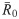
(above) Bivariate posterior distribution of R¯0 and initial susceptible proportion in 2011 for H1N1pdm09. Points indicate accepted ABC parameter sets. Contours indicate posterior credible intervals, such that each contour contains deciles of kernel-smoothed posterior probability density. (below) Marginal posterior kernel density estimate (blue) and prior distribution (red) for R¯0 (left), and initial susceptible proportion in 2011 (right) for H1N1pdm09. Note the difference between high-density regions in the bivariate plot vs the marginals.